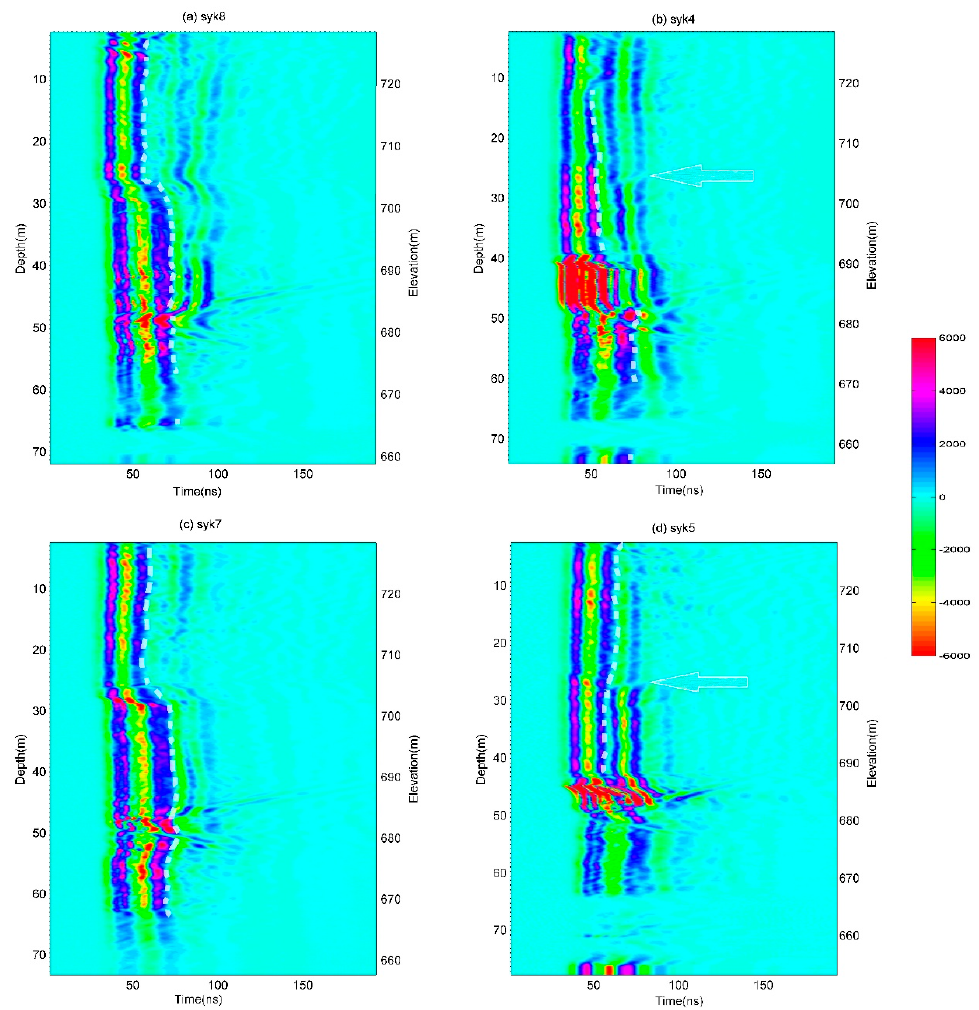
Figure 5. Single-hole reflection radar images for SYK8 ( a ), SYK4 ( b ), SYK7 ( c ), and SYK5 ( d